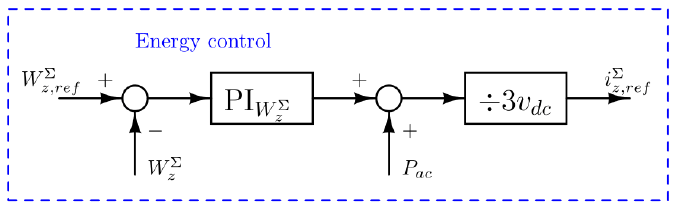
Figure 4. Energy controller.